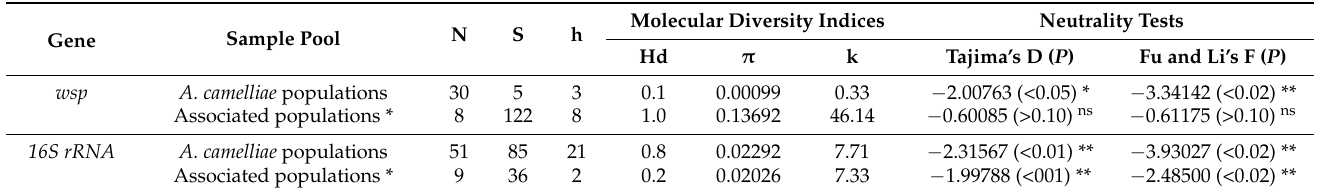
Figure 3. ( A ) Nested PCR detection of the wsp gene revealed a positivity rate range of 91–100%; ( B ) logistic regression analysis on fixed infection across the seasonal temperature. Black line indicates regression line, while grey lines are upper and lower thresholds of 95% confidence interval of pre- dicted line. Regression coefficient was significant (Wald test; p < 0.05). (*) Monthly average temper- ature data were retrieved from the Japan Meteorological Agency (https://www.data.jma.go.jp/; ac-